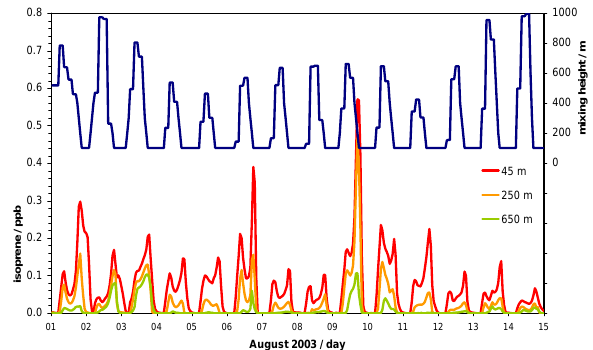
Fig. 12. Time series of modelled hourly isoprene (ppb) for the first, third and fifth level of the EMEP4UK model (mid-level altitudes indicated in the legend) at Writtle for the first 15 days of August 2003 (bottom graph, left hand scale). Modelled boundary layer mixing height (m) is also shown (upper trace, right hand scale).